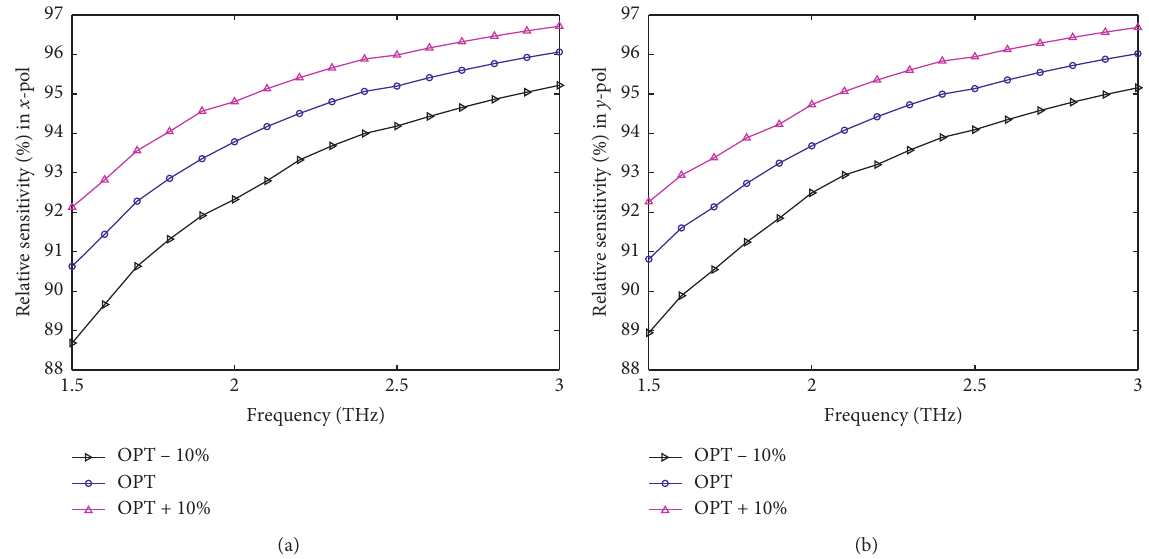
Figure 8: Depiction of the relative sensitivity for the three models as a function of the THz band. (a) x -PoM and (b) y -PoM.